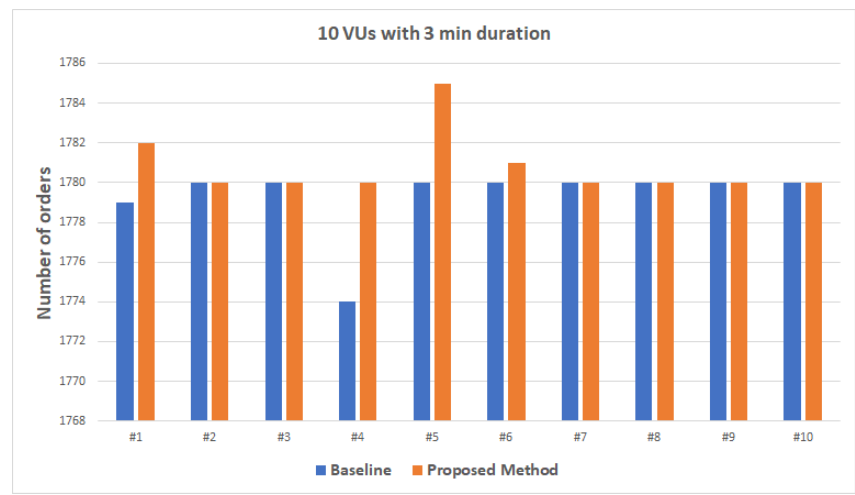
Figure 19. Load Testing—1 virtual user with 3 min duration.